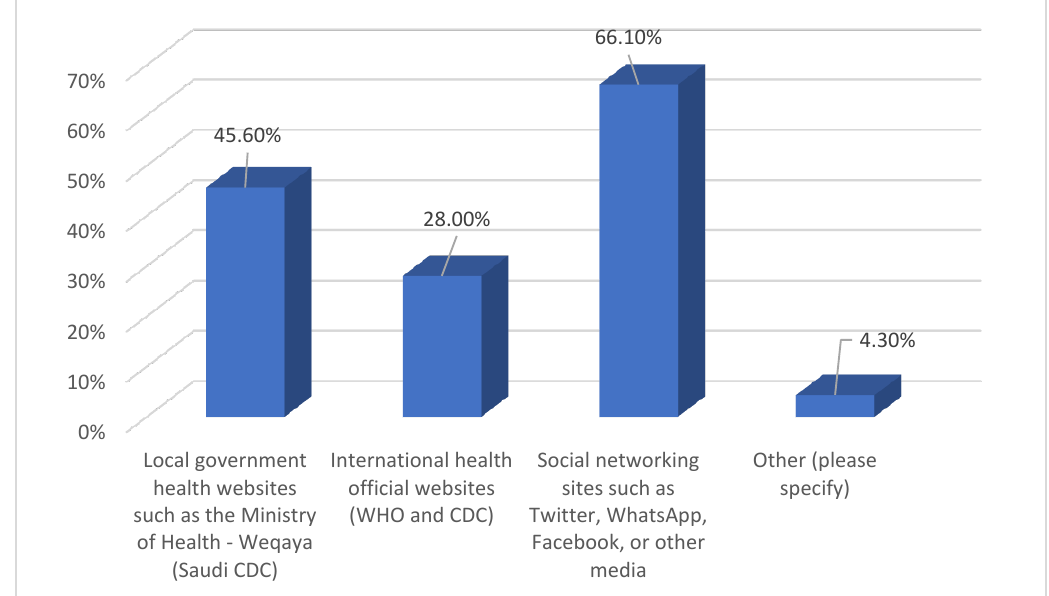
Figure A1. Public perceptions of monkeypox disease transmission modes. (KSA, 27 May to 5 June 2022.)